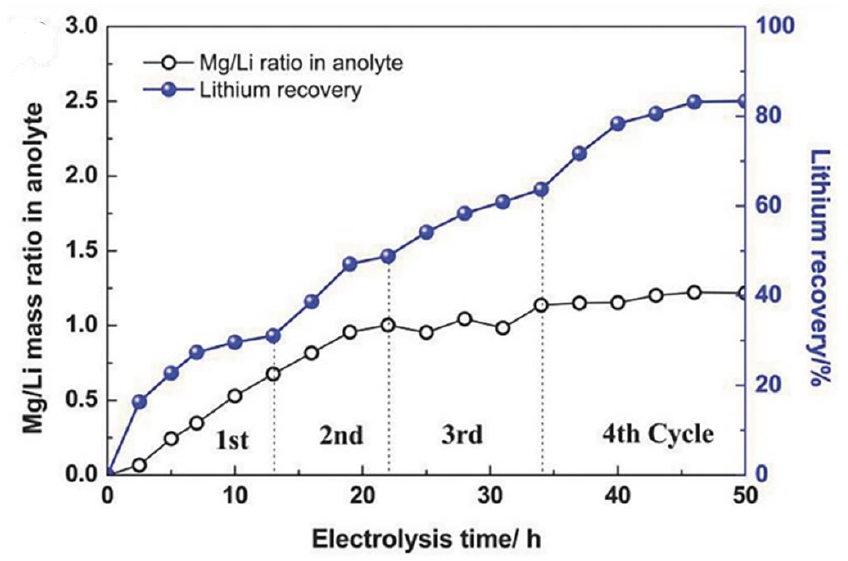
Figure 8. Lithium recovery and Mg/Li mass ratio of the anolyte. Reprinted with permission from Ref. [57]. Copyright 2018 Wiley.